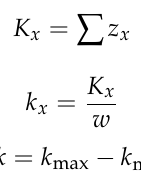
Table 2. Orthogonal experimental results. The four factors and three levels are calibration score (level 1, 0.106; level 2, 0.018; level 3, 0.012), subset size (level 1, 15 pixels; level 2, 23 pixels; level 3, 35 pixels),